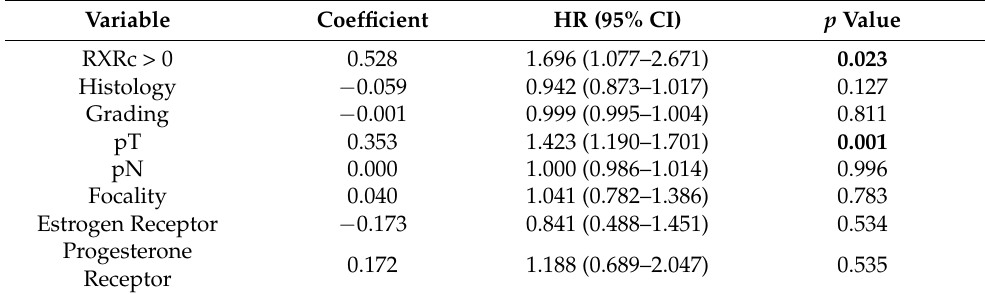
Figure 5. Kaplan–Meier survival analysis of cytoplasmic RXRα positive and negative expression in relation to DFS. Statistical significance is shown as p -values determined using the log-rank-test ( p < 0.05). The risk table demonstrates the mean survival time, SEM and 95% confidence interval (CI) for univariate analyses. Table 5. Multivariate Cox regression analysis of cytoplasmic RXRα expression in relation to DFS.